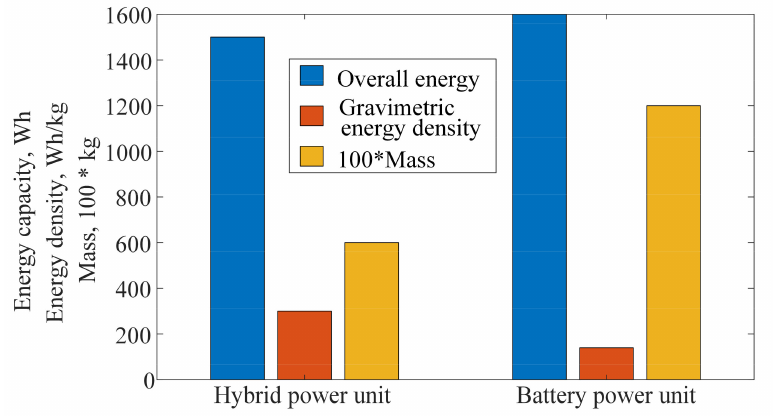
Figure 19. Energy density analysis of hybrid and conventional electric power